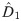
Spectral distances contrast D^1—For the three matrices: Adjacency, combinatorial Laplacian, and normalized Laplacian (from left to right)—Between the 10 × 10 two-dimensional lattice graph and the degree matched configuration model (null model).